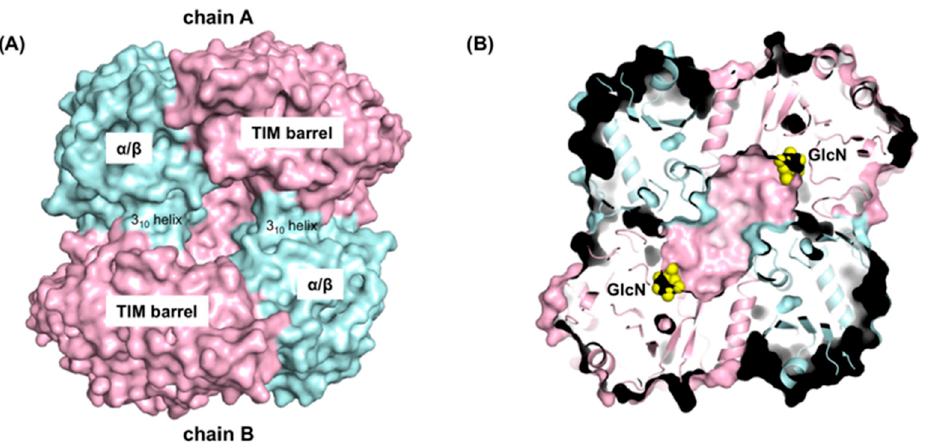
Figure 6. The dimerization interface and the deep active site pocket of GlmA Tk . ( A ) Surface representation of the GlmA Tk dimer (TIM-barrel: light pink, α / β : cyan). The figure was drawn from the same orientation as in the right panel of Figure 1; ( B ) Section drawing of the GlmA Tk dimer containing GlcN molecules (yellow) in the active site. The figure was drawn in the same orientation as in A.